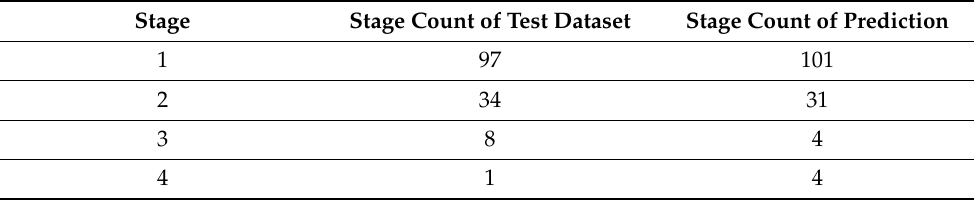
Table 2. Summary of test dataset and framework prediction results.